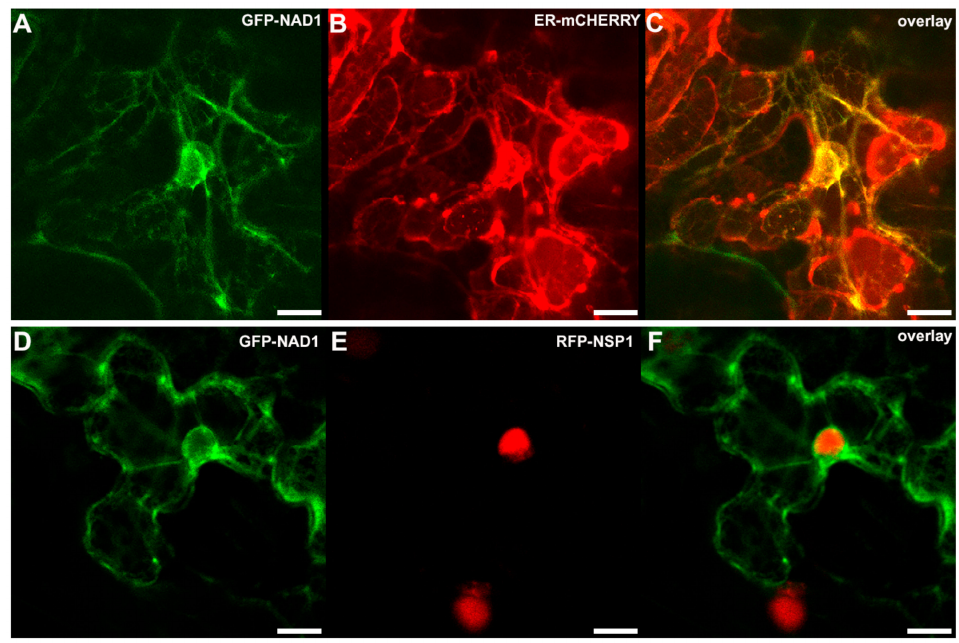
Figure 4. Co-localization of NAD1 with localization control constructs in Nicotiana benthamiana leaf epidermal cells. The p35S::GFP-NAD1 and the ER marker p35S::ER-mCherry or the nucleus marker pUbq10::RFP-NSP1 constructs were co-transformed transiently into Nicotiana benthamiana leaves. The localization of the tagged proteins was imaged by confocal microscopy. The signal of GFP-NAD1 was detected in the endoplasmic reticulum (ER) network ( A , D ), which was confirmed